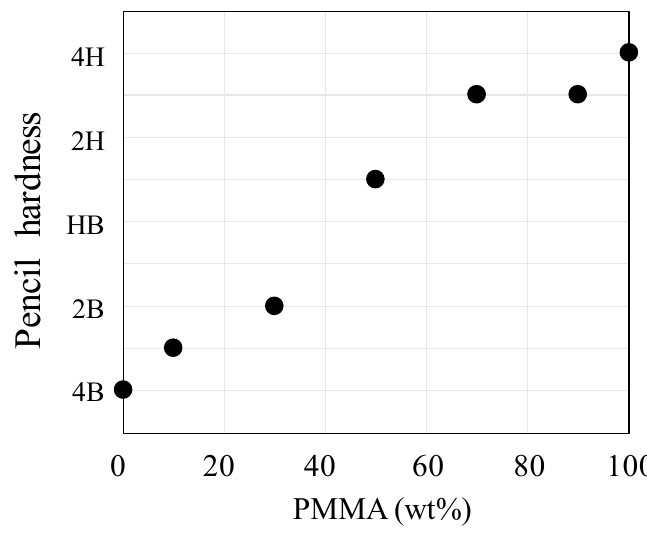
Figure 10. Surface hardness of unstretched PC/PMMA blends at various compositions.